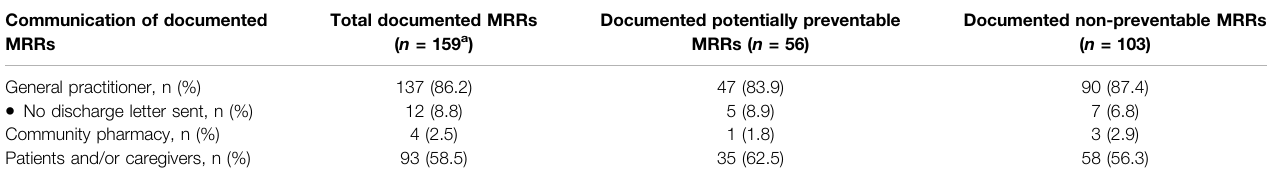
TABLE 4 | Communication of documented potentially preventable and non-preventable medication-related readmissions (MRRs) to patients or caregivers, and/or the next healthcare providers. Communication of documented